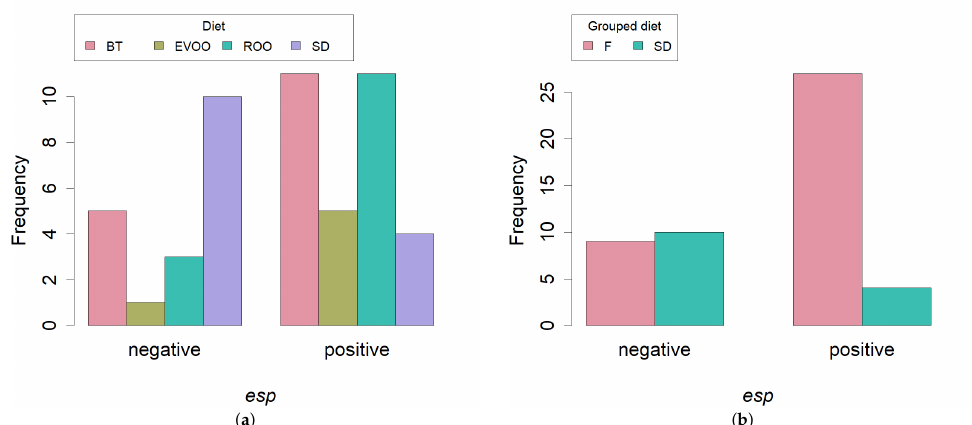
Figure 3. Bar plot of number of strains with presence (positives) or absence (negatives) of the gene esp , distributed among the four diets; ( a ) Fisher’s exact test p = 0.0234) or between SD and high fat diets; ( b ) Fisher’s exact test p = 0.0037). SD, standard diet; BT, butter enriched diet; EVOO, extra virgin olive oil enriched diet; ROO, refined olive oil enriched diet; F, all high fat